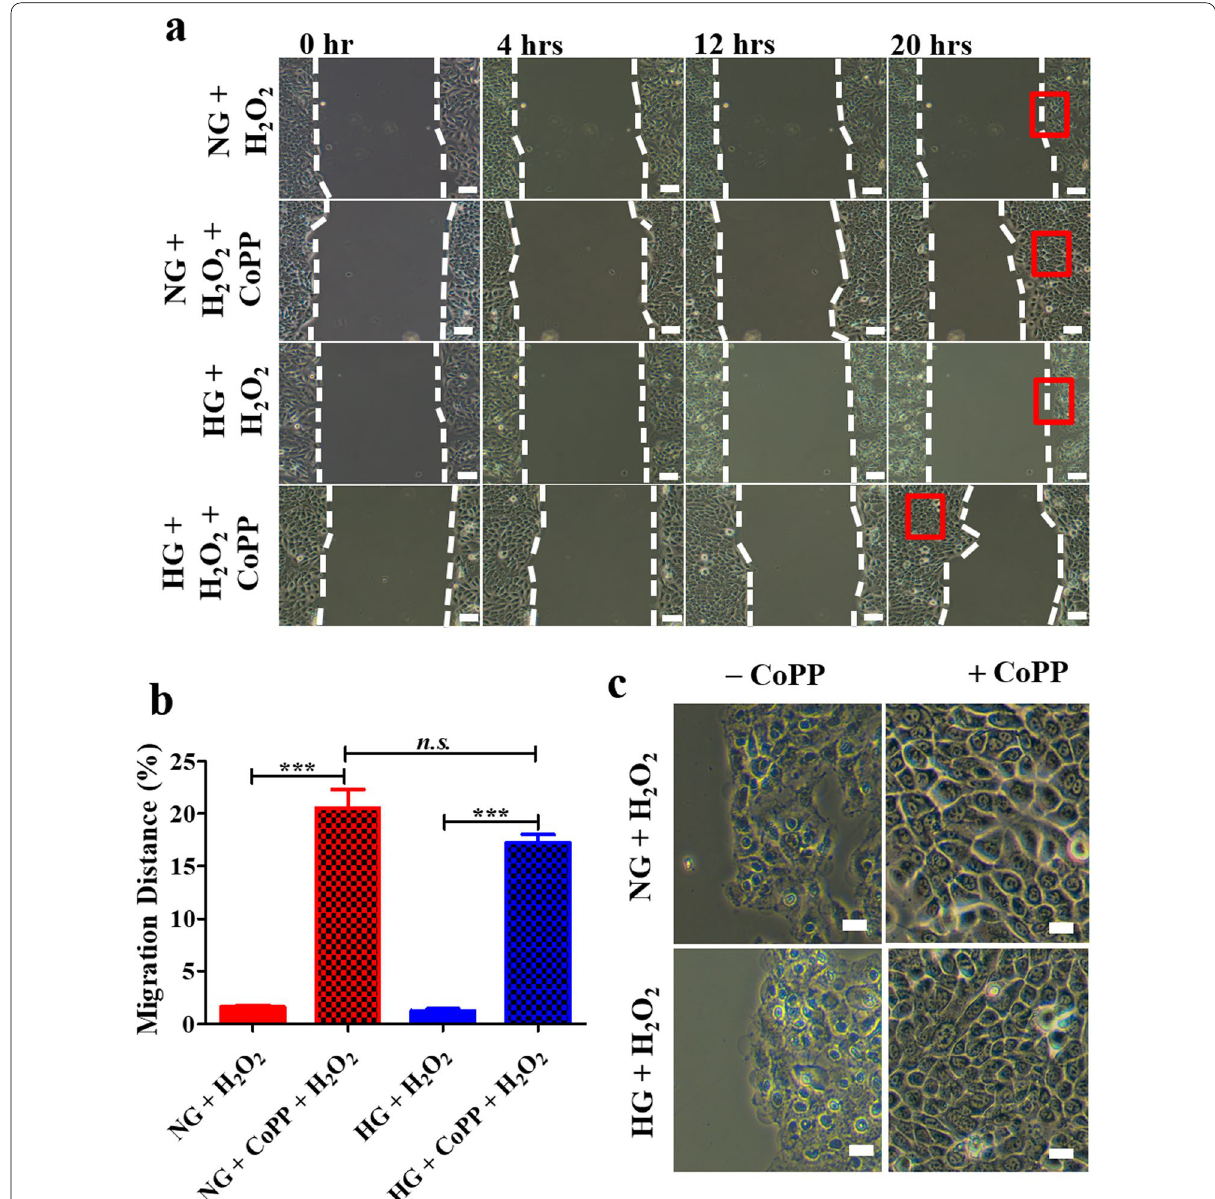
Fig. 4 The protective effect of CoPP pretreatment in HaCaT after exposing to H 2 O 2 ‑containing media. a Time lapse images showing the migrated distance of CoPP‑pretreated HaCaT after exposing to H 2 O 2 ‑containing media, b and the statistical analysis of the migrated distance of each sample at 20th hours of the migration assay. c The enlarged images of HaCaT after completed to the wound healing assay under different conditions (red box in ( a )). Scale bar, 100 μm; *** P < 0.001; n.s. not